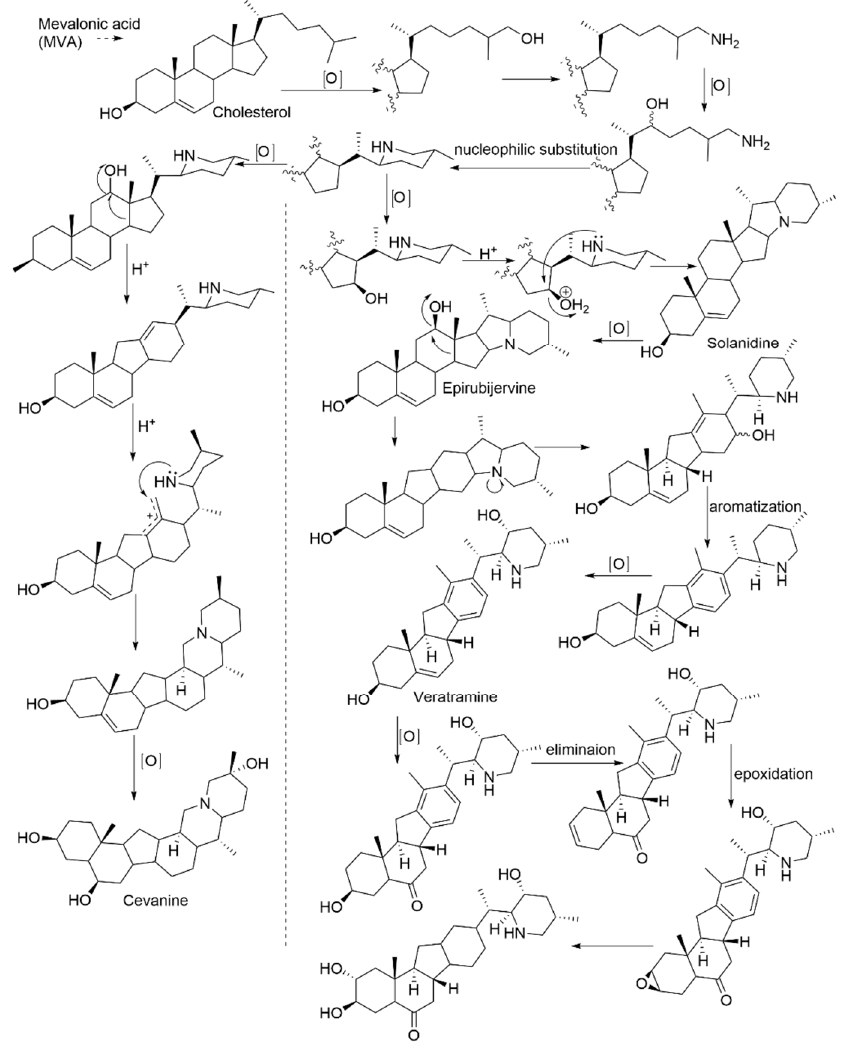
Figure 3. The biosynthetic pathways of Cevanine type isosteroidal alkaloids and Solanidine and